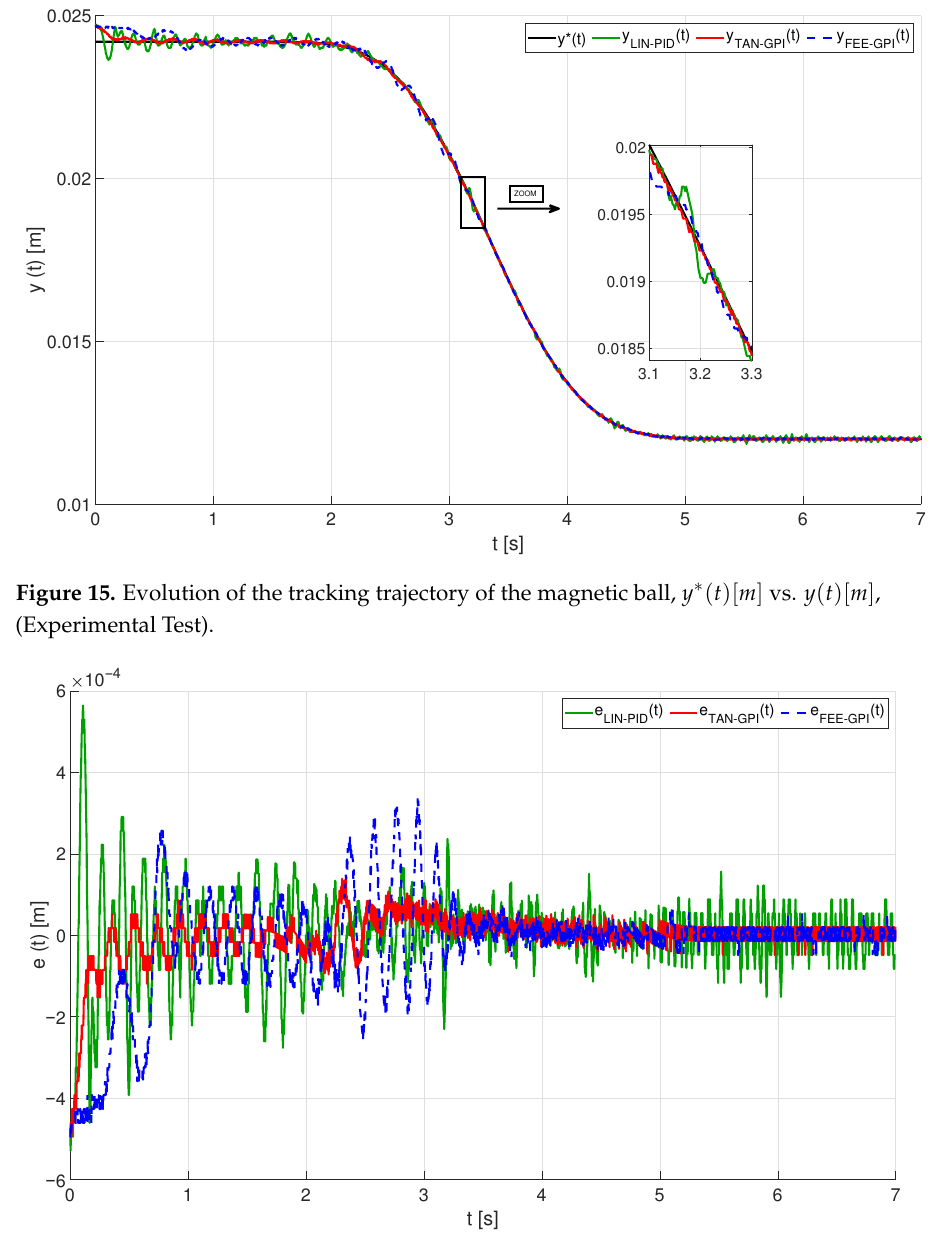
Figure 16. Evolution of tracking error trajectory of the magnetic ball, e ( t ) = y ( t ) − y ∗ ( t )[ m ] , (Experi- mental